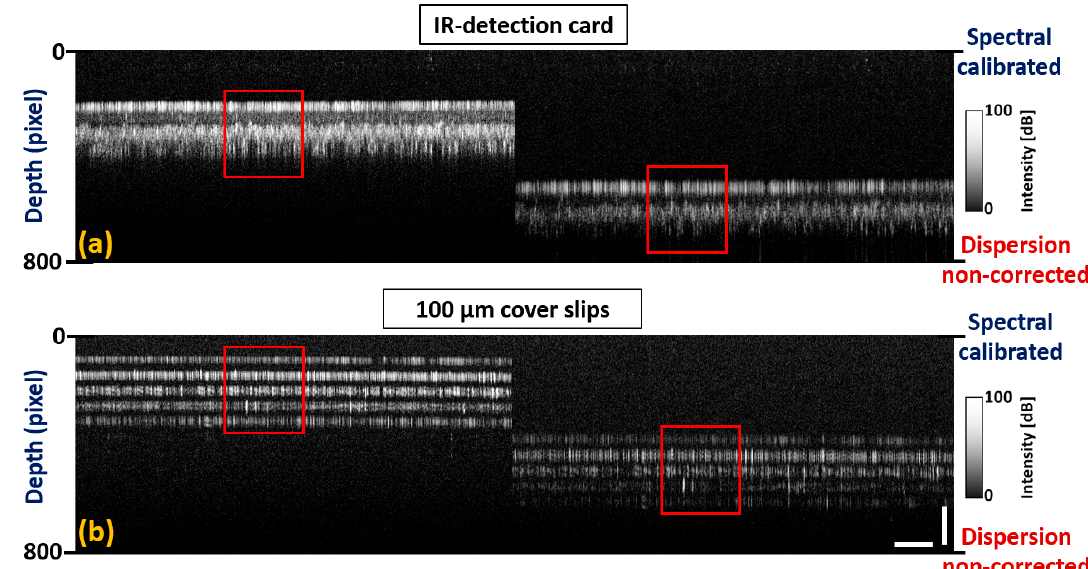
Figure 7. Spectrum calibrated two dimensional OCT images acquired prior to dispersion compensation. ( a ) 2D-OCT images of the infrared (IR)-detection card at top and bottom depth levels. ( b ) 2D-OCT images of five glass cover slips at top and bottom depth levels. Red color square boxes represent a region of interest with non-corrected dispersion. Horizontal scale bar: 1 mm, vertical scale bar: 300 μ m.